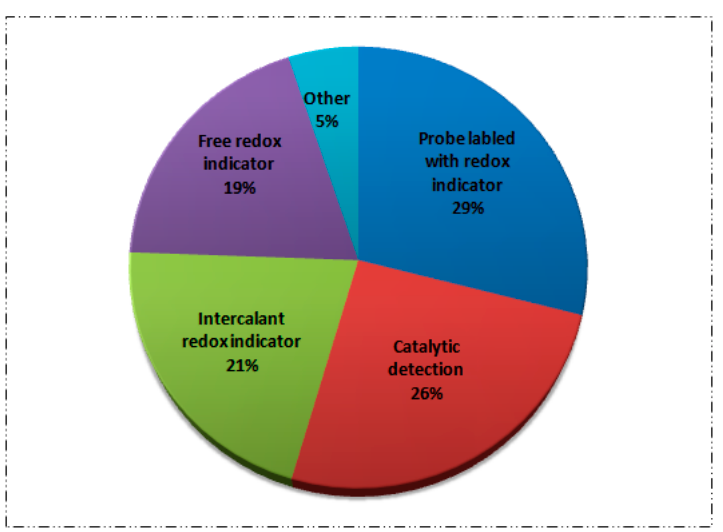
Figure 17. Distribution percentage of di ff erent microRNA strategies detection based on electrochemical biosensors.